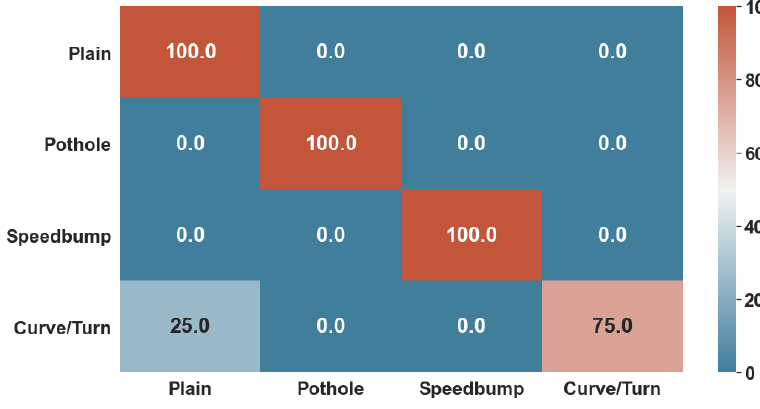
Figure 11. ANN Confusion Matrix over Test